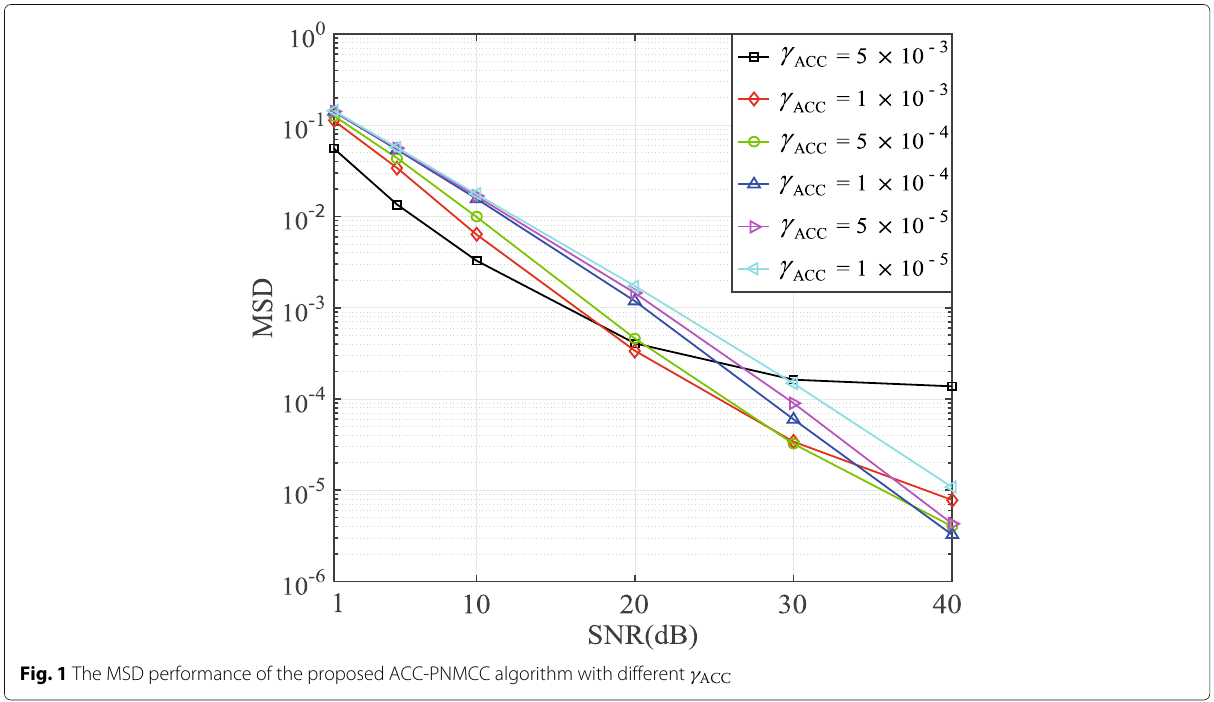
Fig. 1 The MSD performance of the proposed ACC-PNMCC algorithm with different γ ACC ˆ g ( n ) > h ( n ) will contribute to this term as if the norm i i l 0 had been used. Conversely, those coefficients for which ˆ g ( n ) < h ( n ) will contribute to this term as if the norm l i i had been used.